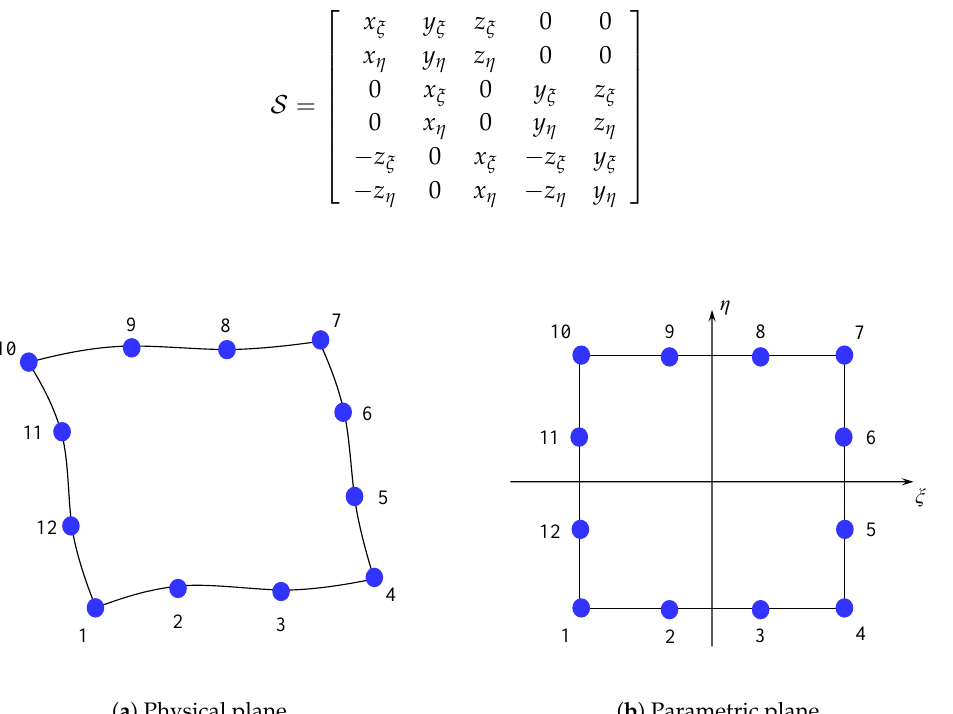
Figure 3. Representation of 12-node cubic patch in physical plane and parametric